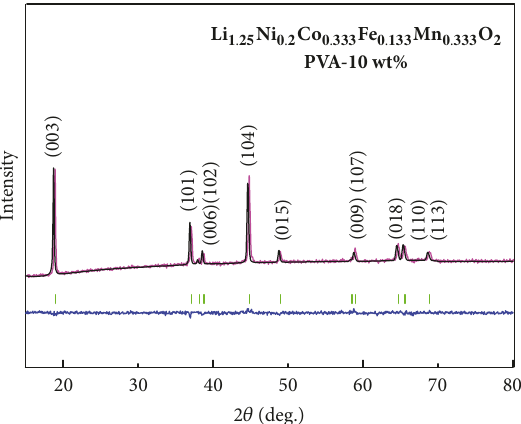
Figure 2: Refined XRD pattern of Li 1.25 Ni 0.2 Co 0.333 Fe 0.133 Mn 0.333 O 2 ( x = 10.0 wt%). The black crosses represent the measured points, and the pink curve is the fitted line. The green marks indicate the peak positions, and the blue line is the error